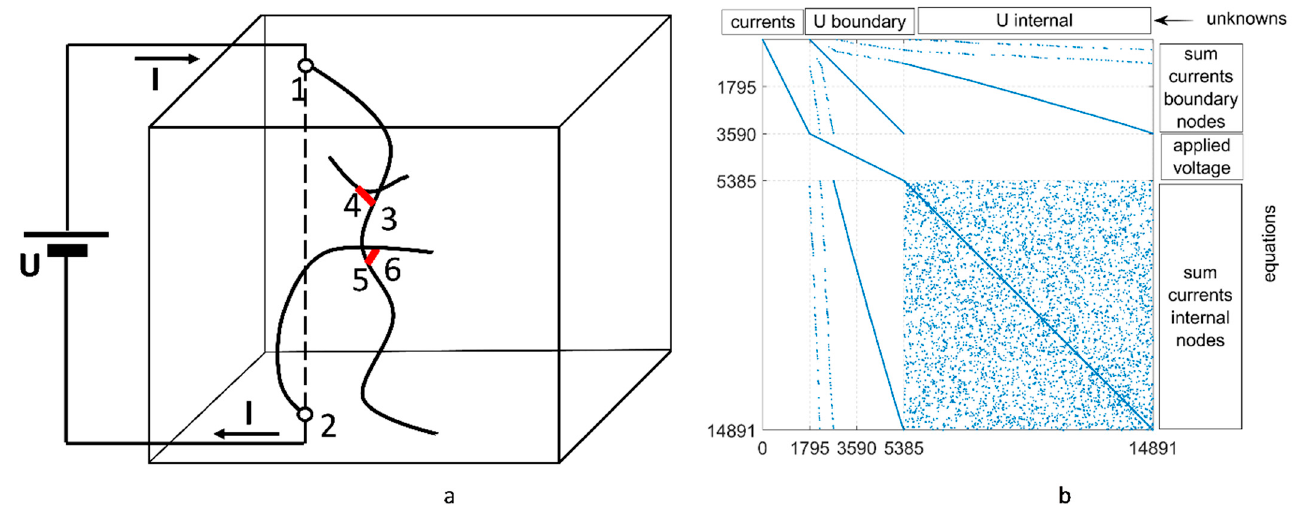
Figure A1. Nodal analysis: ( a ) node pairs at contacts between CNTs, and 4, 5, and 6, boundary nodes, 1 and 2, and currents with the applied voltage; ( b ) the structure of the matrix of Kirchhoff’s Equations (corresponds to the A-MW case shown in Figure 2c).